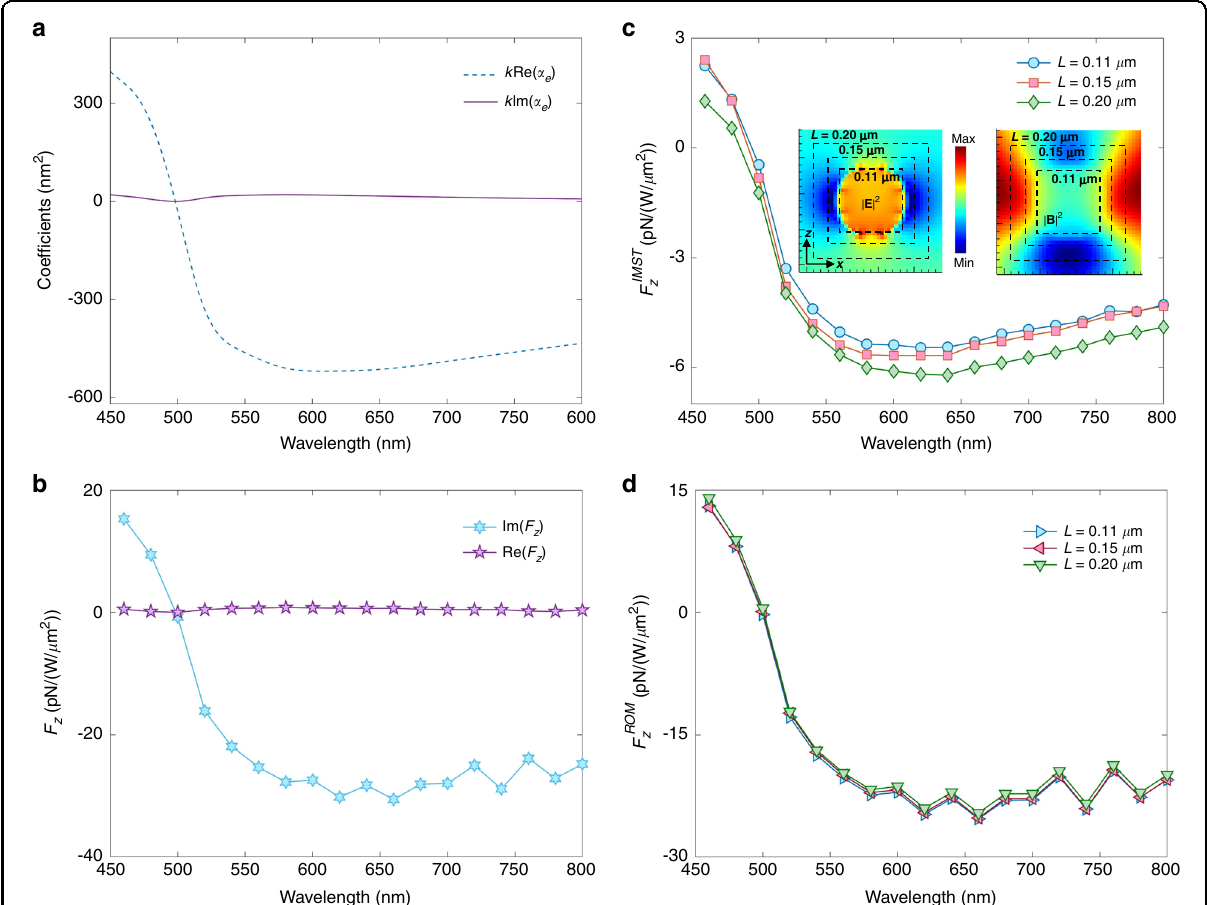
Fig. 5 Same as Fig. 4 for a sphere of a hypothetical material, that we call Au 3 , whose refractive index has a real part identical to that of Au, but its imaginary part is arti fi cially set to zero. a Calculated polarizibility. b Real and imaginary parts of complex Lorentz force. c IMST and d ROM components of of the